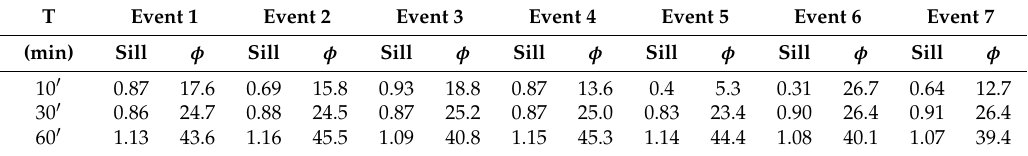
Table 3. Fitted parameters sill and range ( φ , in km) for an averaged exponential semivariogram model. T